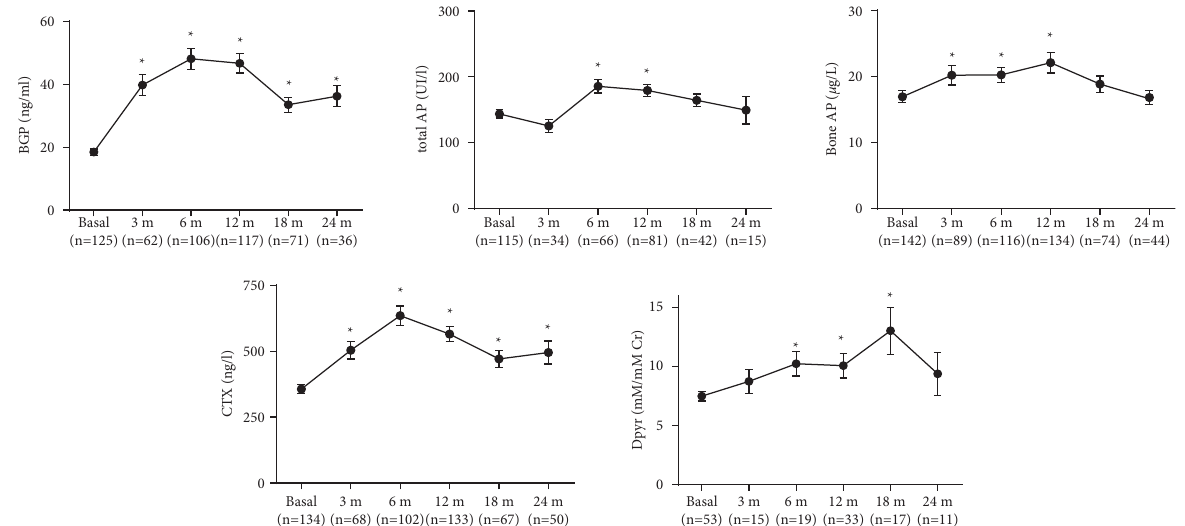
Figure 2: Changes in bone formation and resorption markers during treatment with teriparatide. Wilcoxon signed-rank test. Mean ± SEM. ∗ Indicates signifcant diferences vs. basal ( p < 0 .